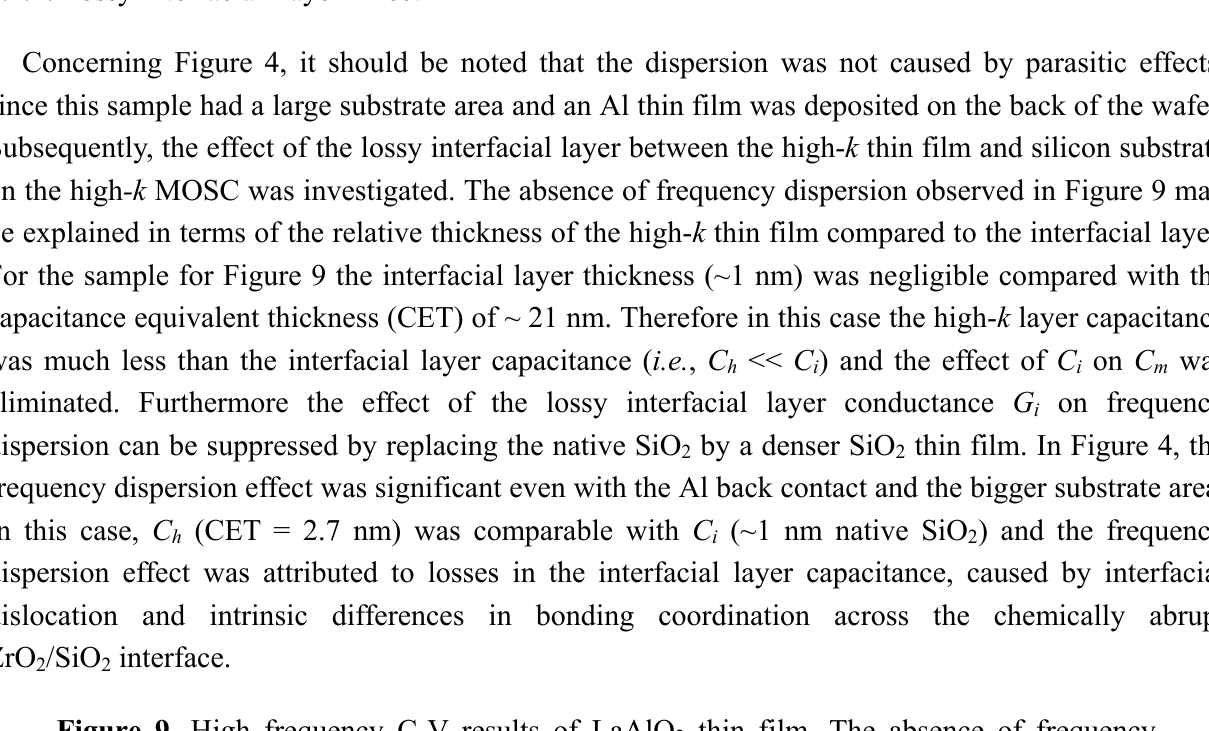
Figure 9. High frequency C-V results of LaAlO thin film. The absence of frequency 3 sample is observed with an effective area of 6 cm 2 with back Al dispersion in the LaAlO 3 contact. C is the capacitance in the accumulation range acc